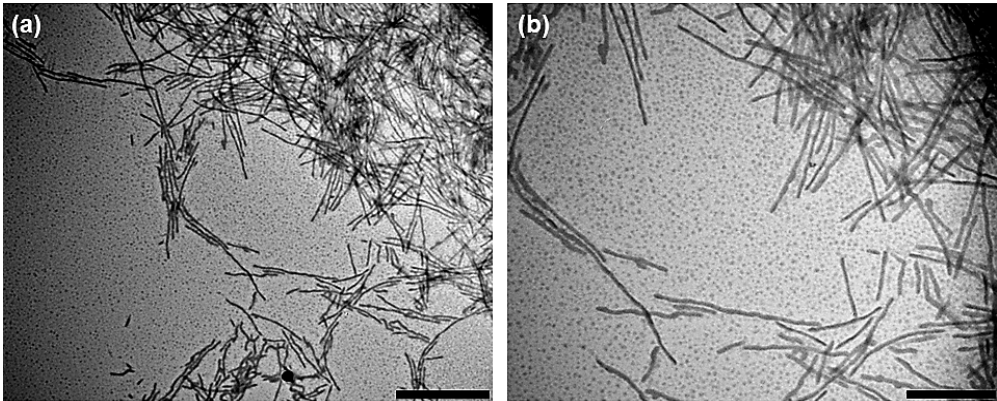
Figure 3. ( a , b ) Bright field TEM images of drop-casted solution of cylindrical micelles prepared by the self-assembly of BCP 8a (0.33 mg/mL) in mixtures THF/2-propanol = 2/1. Scale bars correspond to 1000 nm ( a ) and 500 nm ( b ).